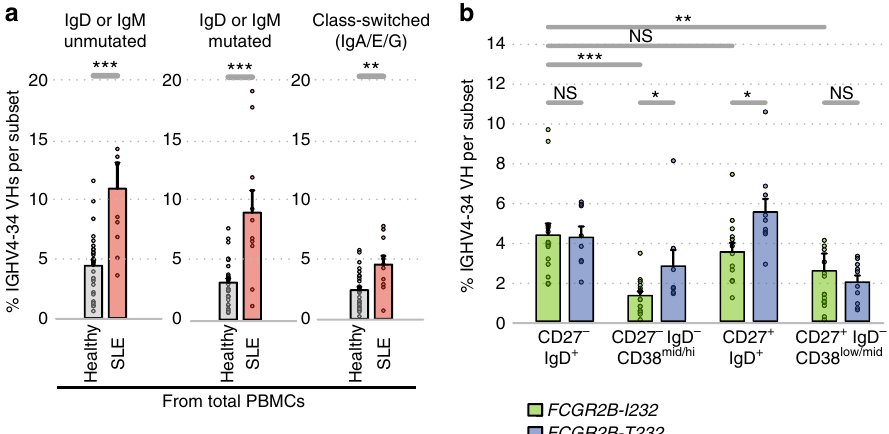
Fig. 7 Effect of FCGR2B genotype on the IGHV gene repertoire in humans. a Percentage of IGHV4 - 34 gene usage from IgH sequencing from total PBMCs from healthy individual versus SLE patients during active disease, grouped according to IgH subtype: unmutated IgD or IgM IgH sequences, which are largely derived from naive B cells; mutated IgD or IgM IgH sequences which are derived from B cells having undergone SHM, thus evidence of antigenic stimulation; and class-switched IgH sequences, therefore derived from B cells post-antigenic stimulation. b Percentage of IGHV4 - 34 gene usage in cell- sorted populations from FCGR2B genotyped healthy individuals per population. * denotes differences between genotypes or cell subsets with p -values < 0.05, ** denotes p -values < 0.005, *** denotes p -values < 0.0005 (by ANOVA with age as a covariate), NS: non-signi fi cant p